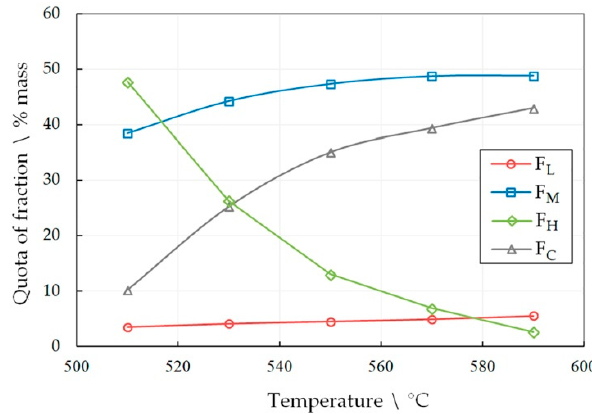
Figure 2. The dependence of the share of fractions F L , F H , F M and F C in the liquid product of LDPE pyrolysis for 60 min on temperature.